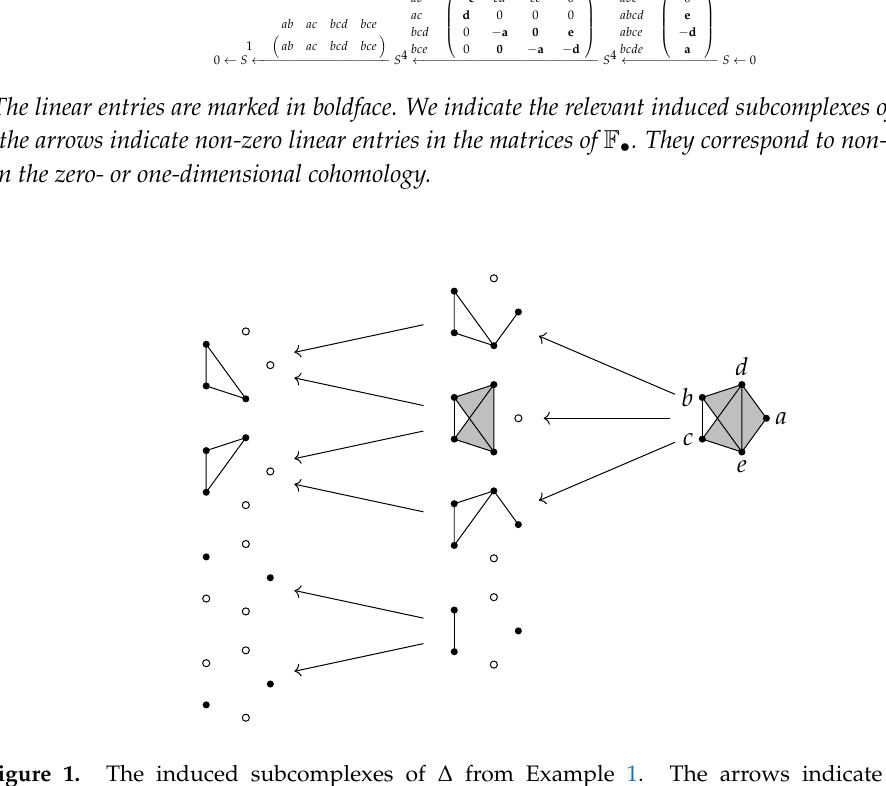
Figure 1. The induced subcomplexes of ∆ from Example 1. The arrows indicate non-zero linear